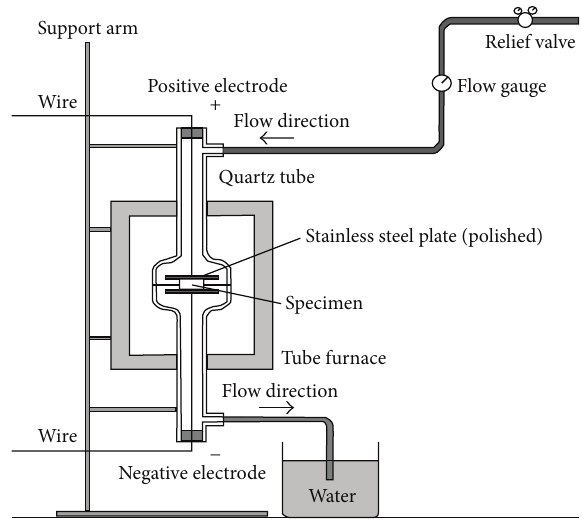
Figure 1: The heating apparatus and specimen arrangement.